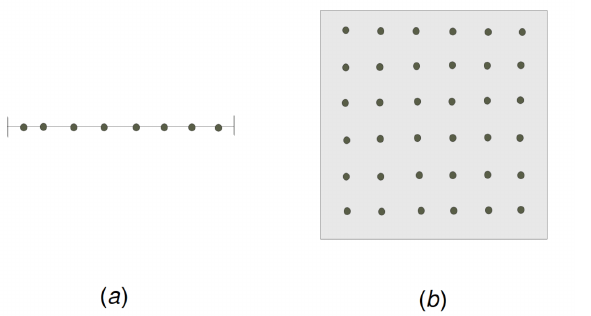
Figure 3. ( a ) Sensors at the anchor positions on the unit interval. ( b ) Sensors at the anchor positions on the unit